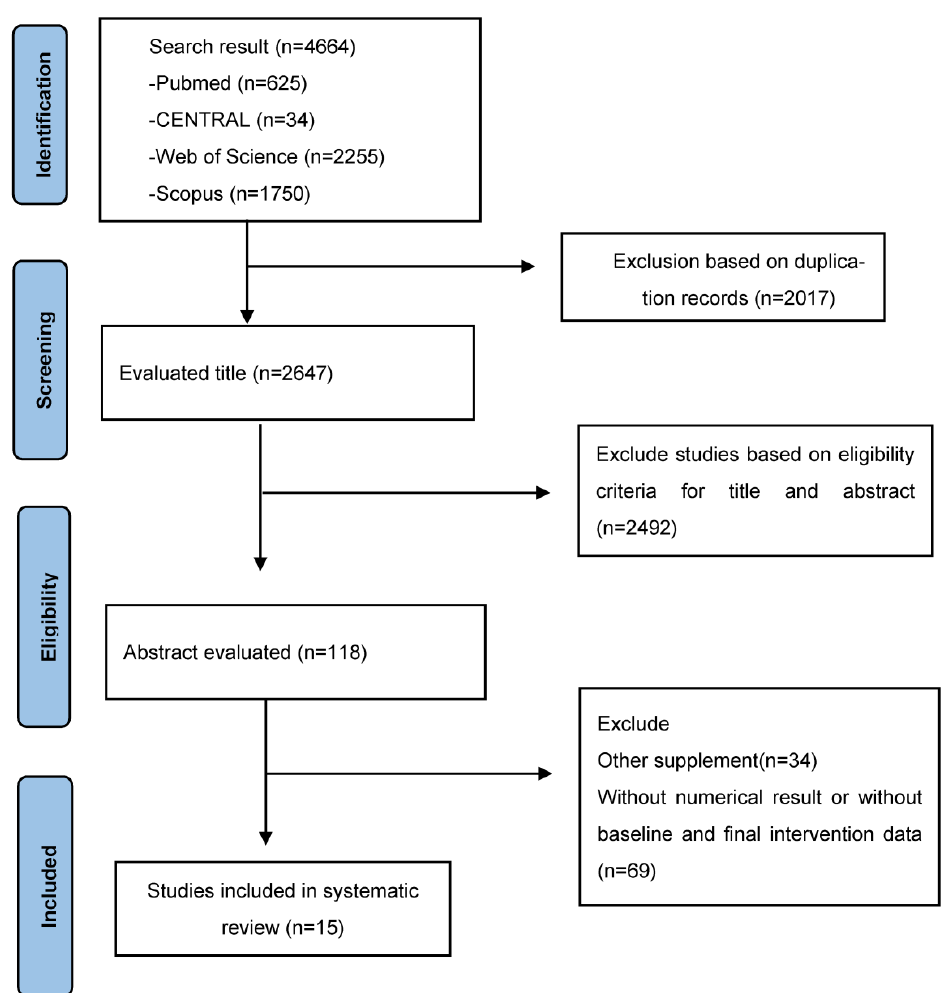
Figure 1. The PRISMA flow diagram depicts the process of selecting studies for systematic review and meta-analysis.